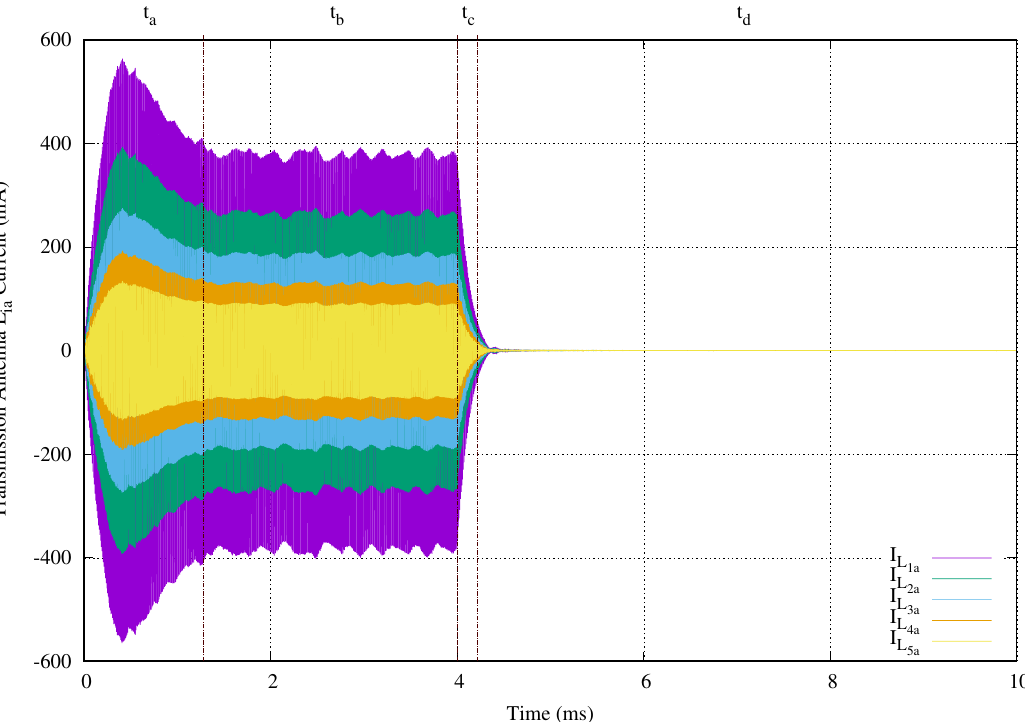
Figure 10. Currents in each transmission antenna of a network branch with five stages when a 4 ms tone of 134.2 kHz is